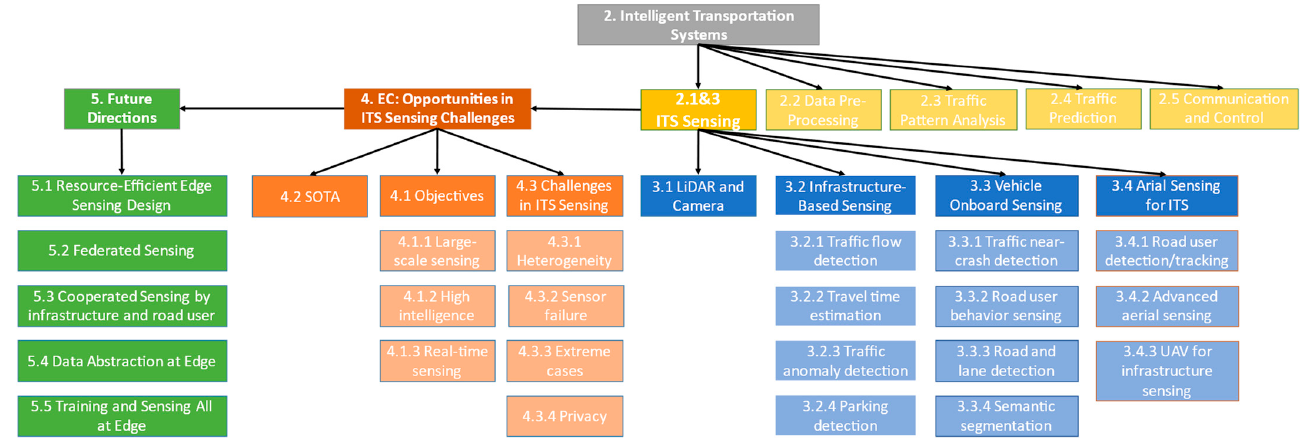
Figure 2. The structure of the content in this review paper.